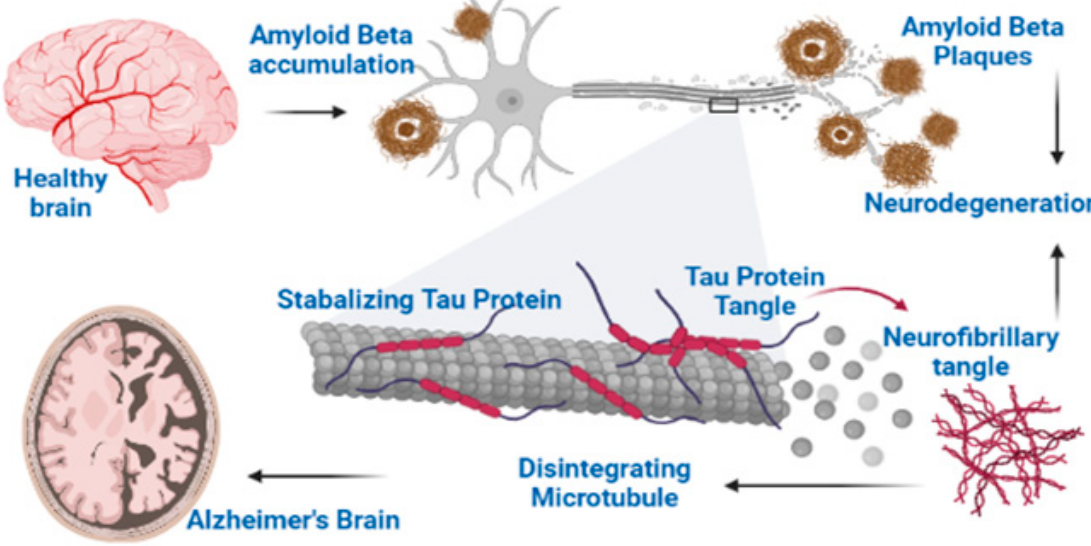
Figure 1. Two major hallmarks of Alzheimer’s disease: A β and NFTs.